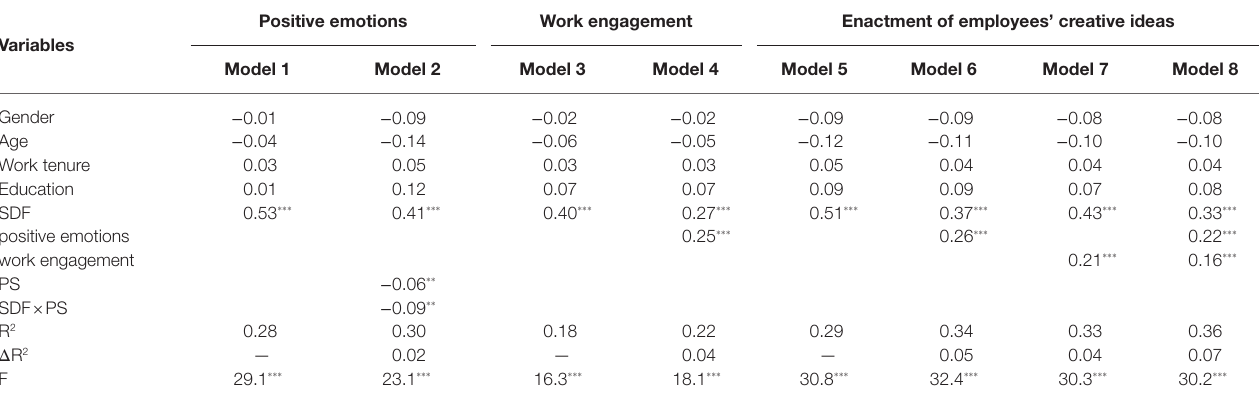
TABLE 2 | Hierarchical regressions for main variables.